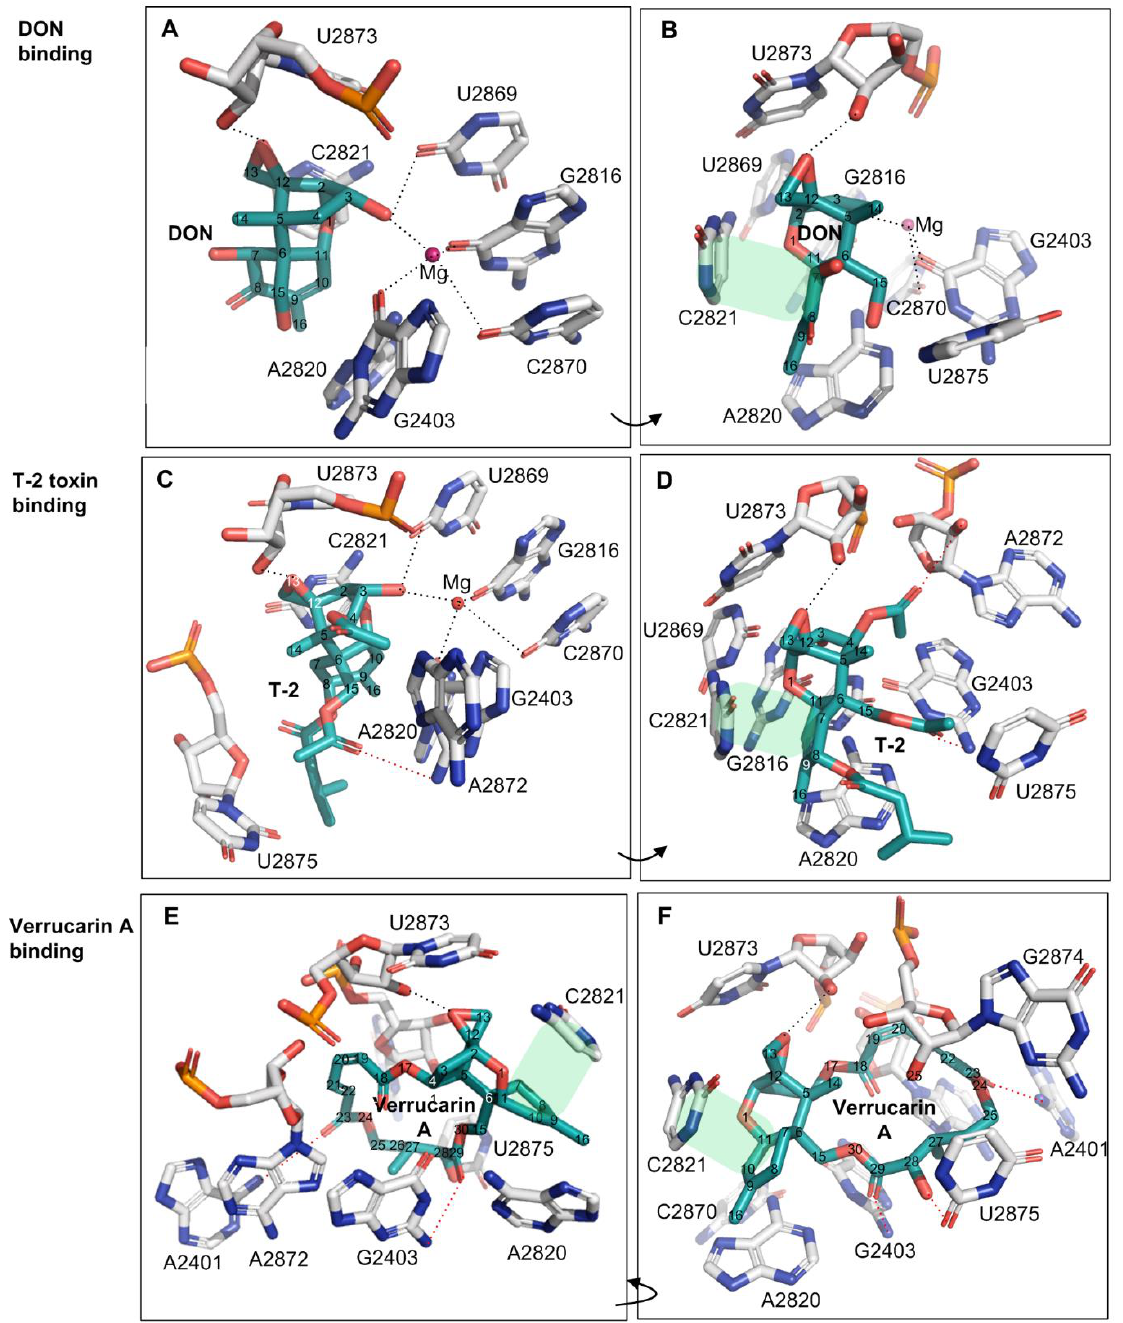
Figure 2. The binding of trichothecene mycotoxins of DON, T-2 toxin and verrucarin A to yeast 80 S ribosome. ( A , B ): The binding contacts of DON to 25S rRNA; ( C , D ): The binding contacts of T-2 toxin to 25S rRNA; ( E , F ): The binding contacts of verrucarin A to 25S rRNA. The hydrophobic stacking interaction between two rings was shaded in light green, and the additional contacts relative to DON were labeled in the red dash lines.